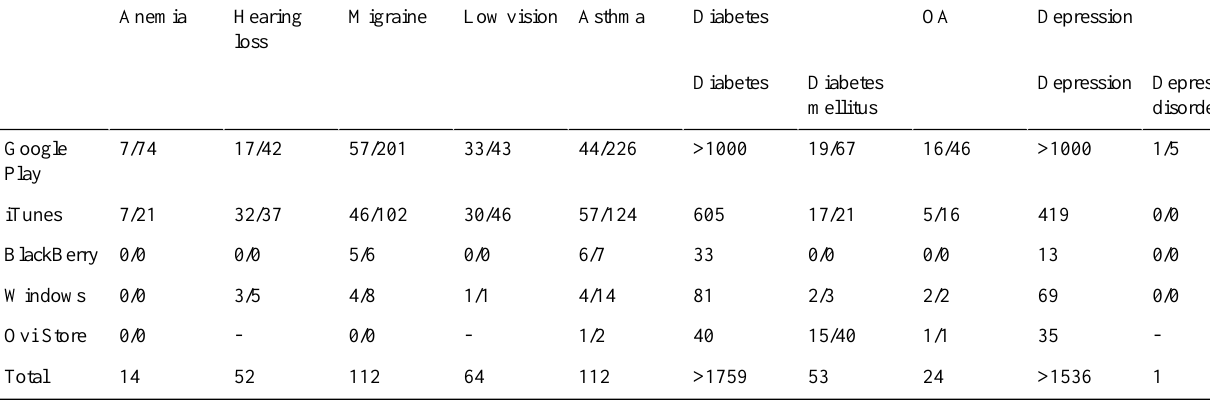
Table 2. Results of the commercial apps